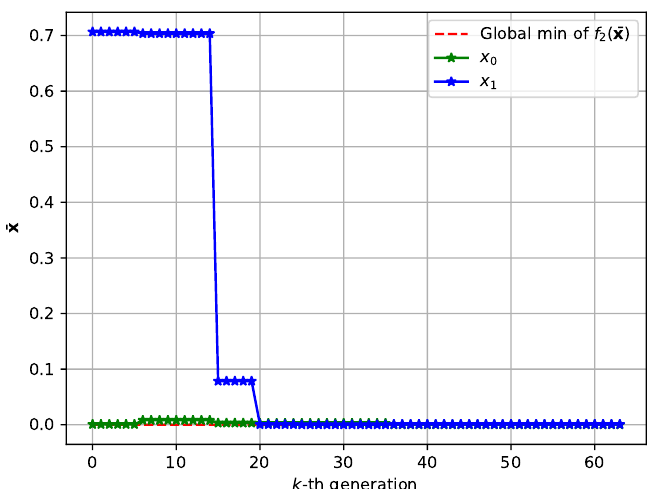
Figure 18. Convergence of the dimensions x 0 and x 1 of f 2 ( ¯x ) in slave node.